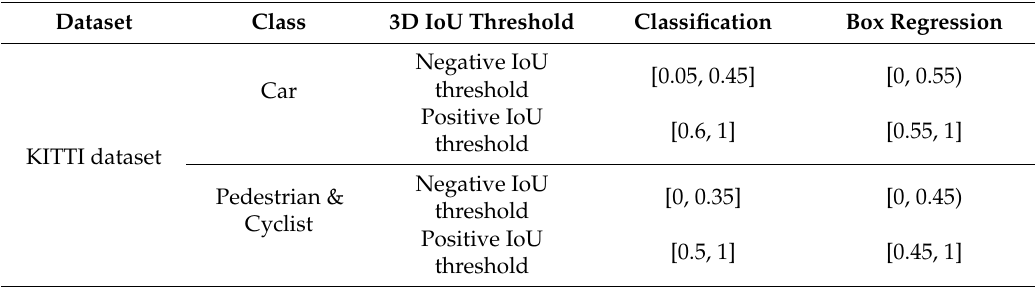
Table 1. Intersection over union (IoU) threshold settings for box refinement and